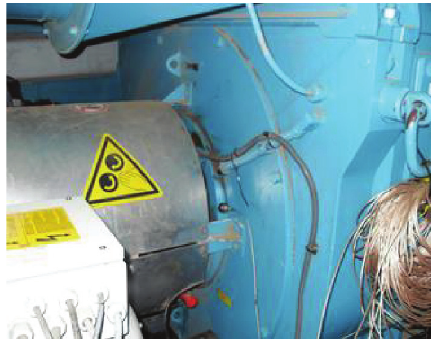
Figure 13: The installation location of the acceleration transducer on the front bearing of